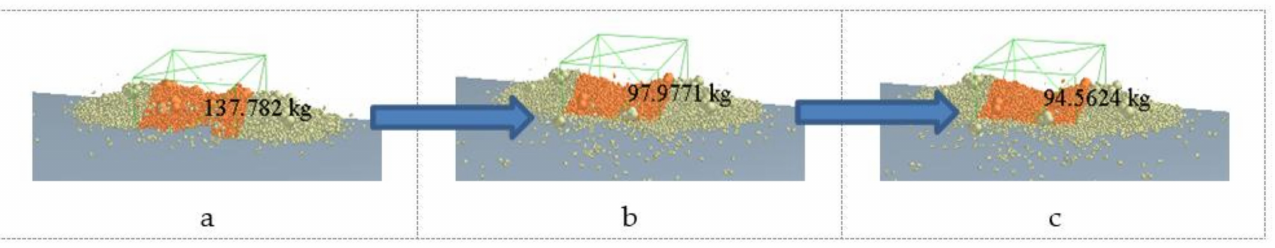
Figure 15. Simulation process of airduct mouth direction angle, 30 ◦ . ( a ) soil ridge mass at 0.5 s/(kg), ( b ) soil ridge mass at 1.5 s/(kg), ( c ) soil ridge mass at 2